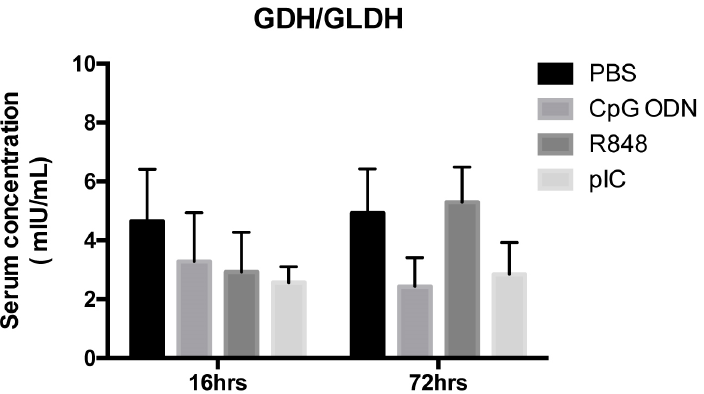
Figure A4. Detection of liver-specific serum enzyme GDH/GLDH in wt BALB/c mice following systemic